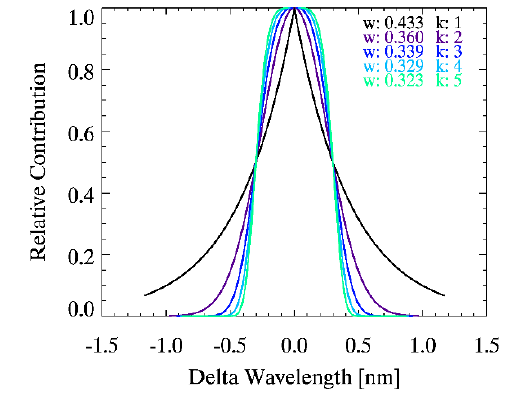
Figure 4. Variation of SRFs with changing asymmetric Super-Gaussian (ASG) coefficients: w determines the width, and k is related to the shape of the function. When k = 2, the ASG function is identical to a Gaussian. The values of a k and a w for the ASG function are zero. Table 5. Sensitivity results of the algorithm without SRF parameters applied to solar irradiances convolved with different SRFs.